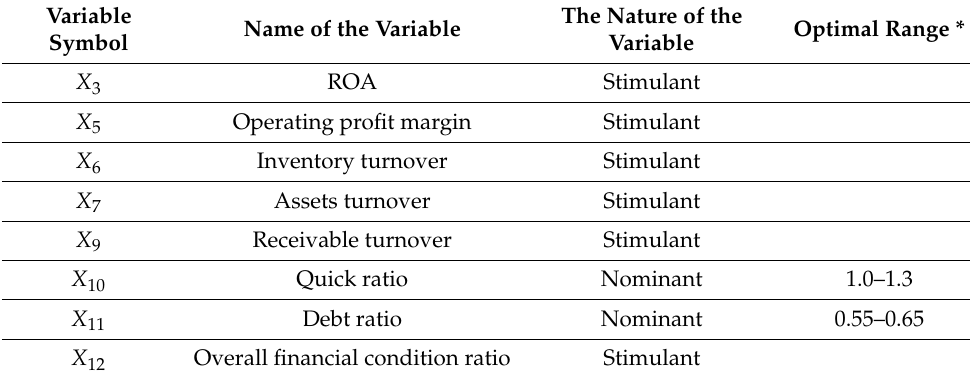
Table 5. The set of diagnostic features after